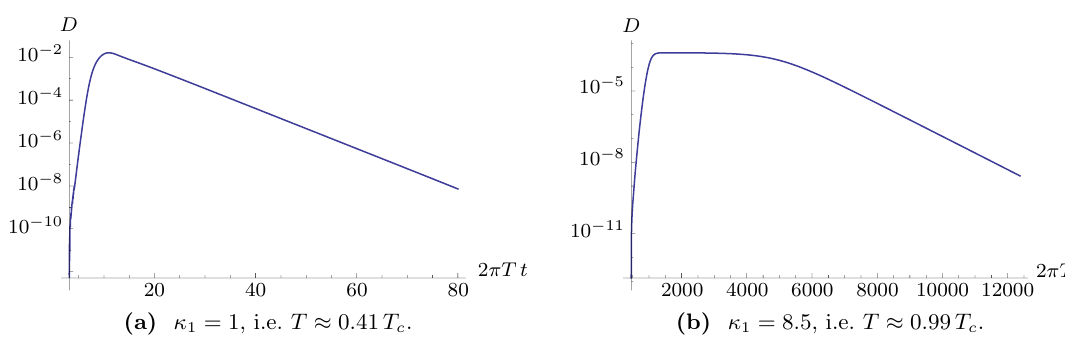
Figure 10. A log plot of D as de(cid:12)ned in (3.8) for di(cid:11)erent Gaussian quenches, showing the late- time exponential decay of the e(cid:11)ective IR degrees of freedom due to screening. Signs of critical slowing down can be seen in (b) as the system is close to the critical temperature T c